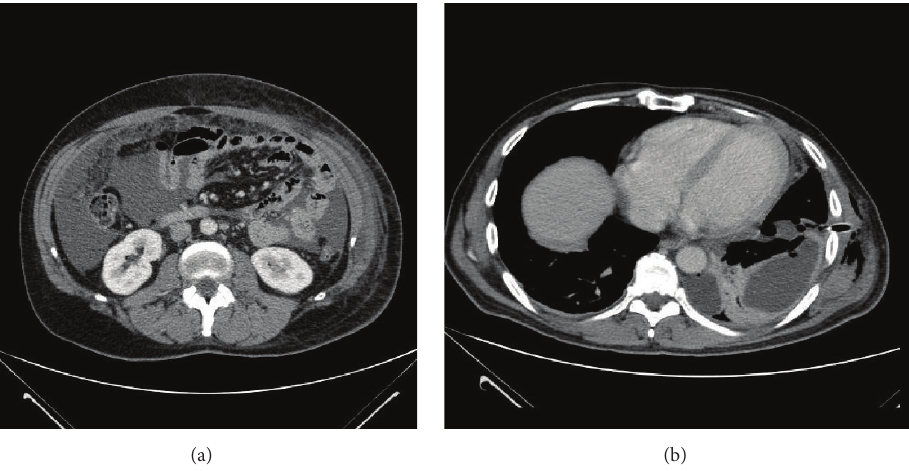
Figure 1: (a) At the time of diagnosis diffuse peritoneal fluid in the abdomen and peritoneal implants are presented through the CT scan. (b) Pleural effusion on the left (progressive disease) presented after the third cycle of Capecitabine/Oxaliplatin